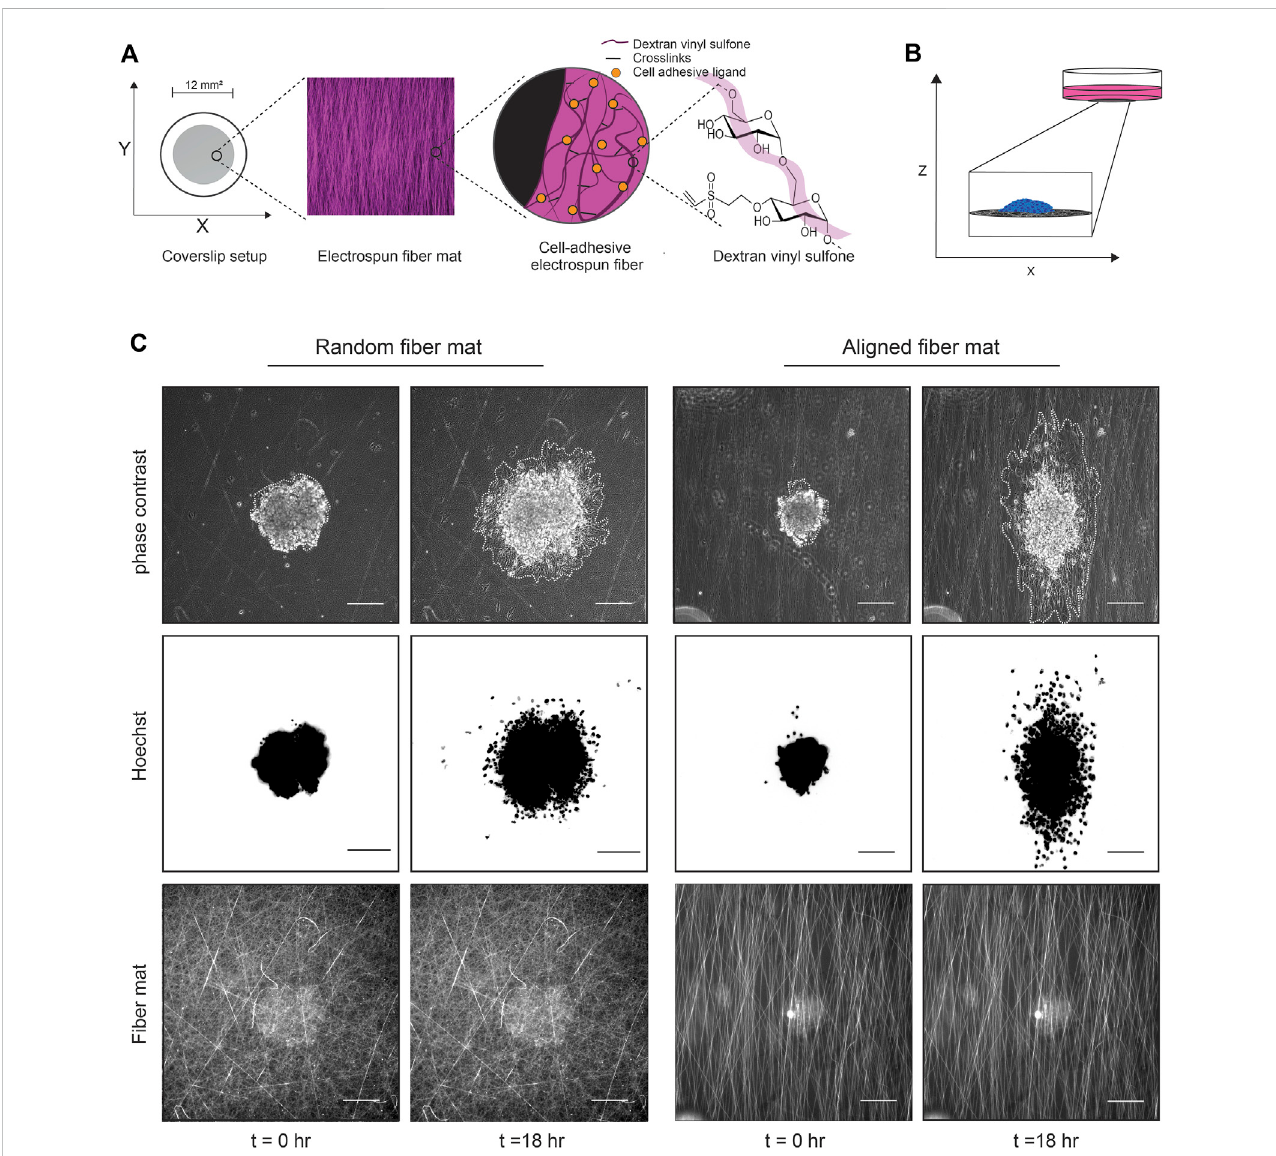
FIGURE 1 Experimental setup using DexVS fi bers and cancer cell spheroids. (A) Cartoon depicting the method used to generate the fi bers. Dextran is reacted with vinyl sulfone to create DexVS, which then is mixed with LAP and electrospun to create fi ber mats on coverslips. (B) Cartoon depicting the 2D spheroid migrationassay.Afterfunctionalizationwithcollagen,cancercellspheroidsareplatedonto fi bermatsofinterestandimagedovertimetoassessmigration. (C) RepresentativephasecontrastimagesofaMDA-MB-231spheroidmigratingonrandomoraligned fi bermatstakenatthetimes0and18 h.Spheroidsare outlined in white to delineate the extent of cell